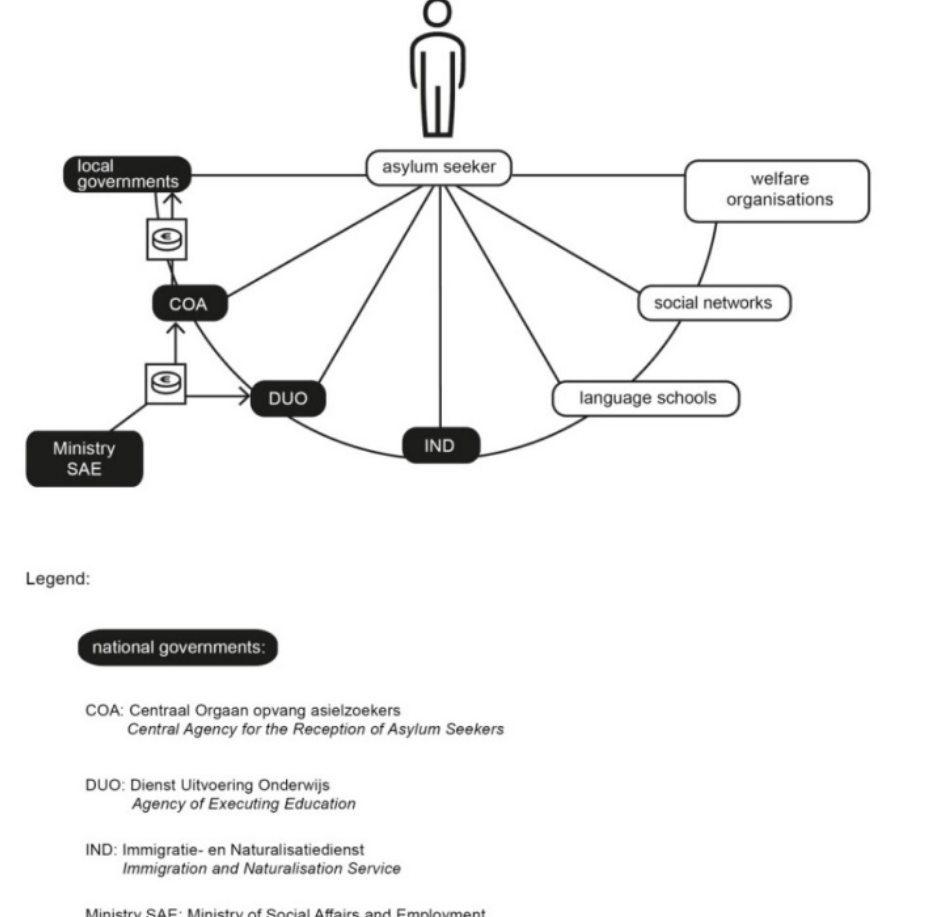
Figure 1. Actors in charge of asylum seekers’ integration (figure drawn by the author based on Rekenkamer, 2017, p. 7). Urban Planning, 2018, Volume 3, Issue 4, Pages